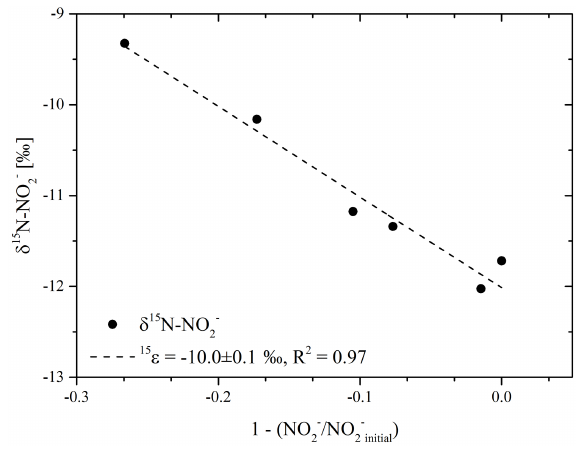
Figure 4. Nitrite isotope values vs. the remaining fraction of ni- trite during the Elbe flood corresponding to the filled data points in Fig. 1b and c. The dashed line indicates the apparent isotope effect during net nitrite consumption with a slope of − 10.0 ± 0.1‰ and R 2 of